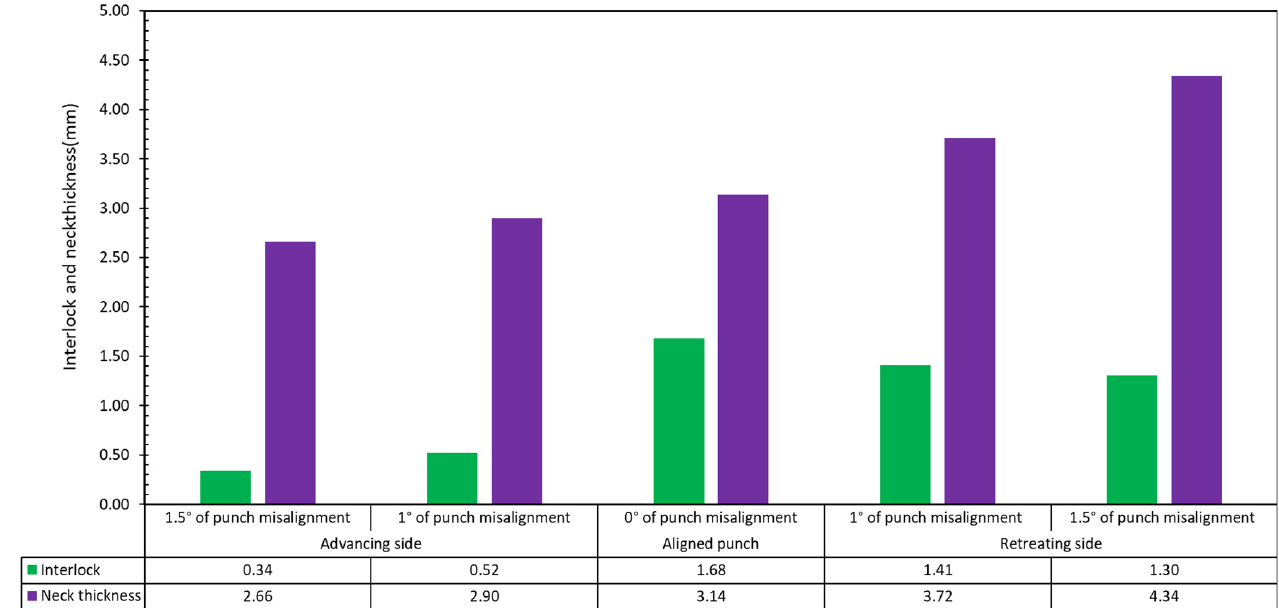
Figure 22. Bar chart of interlock for joint 12–8 mm with 0°, 1° and 1.5° misalignment (S4, S7 and S8).